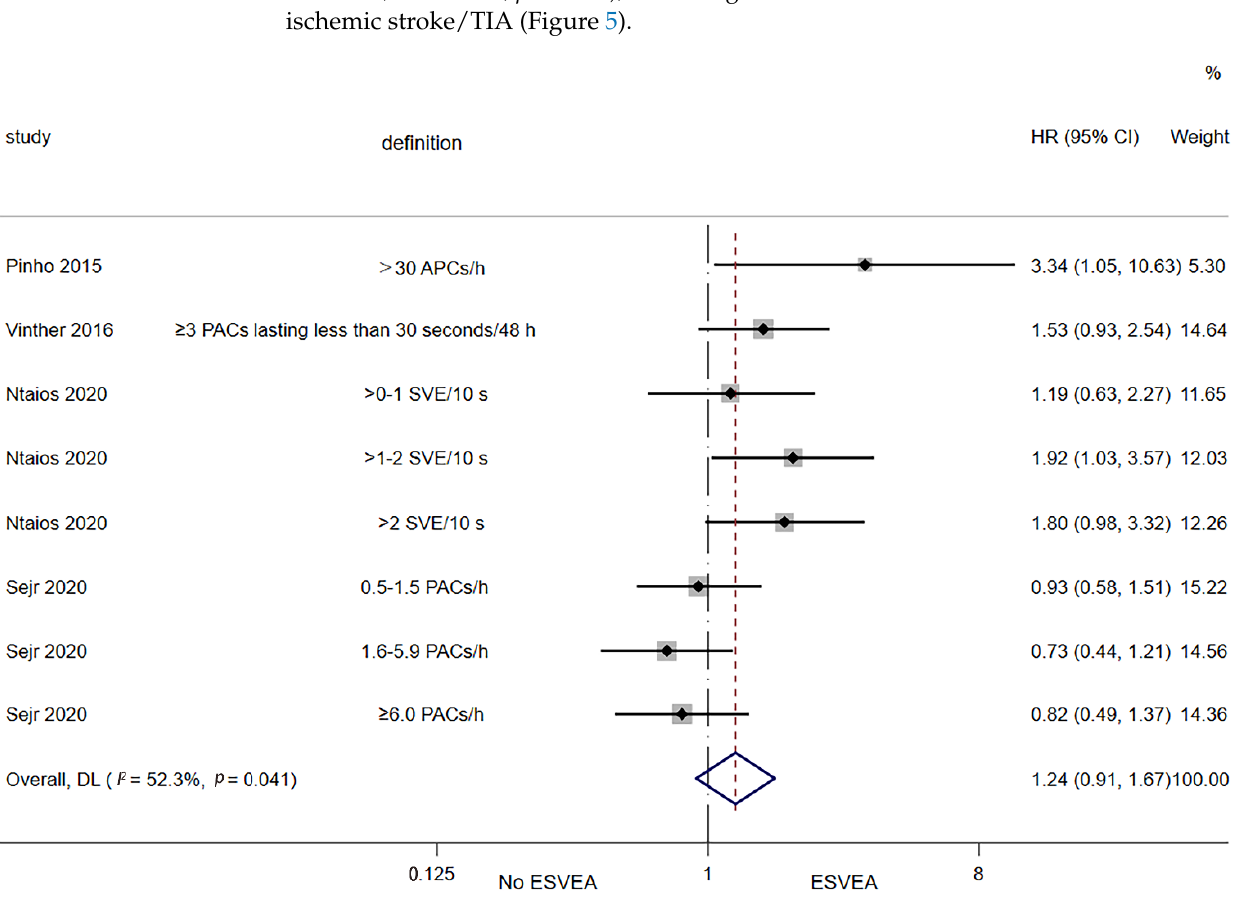
Figure 5. Forest plot of ESVEA and the risk of recurrent ischemic stroke/transient ischemic attack. Abbreviations: APCs—atrial premature complexes; PACs—premature atrial complexes; SVE—supraventricular extrasystoles; ESVEA—excessive supraventricular ectopic activity; HR—hazard ratio; CI—confidence interval. Definition represents the definitions of ESVEA in different studies.